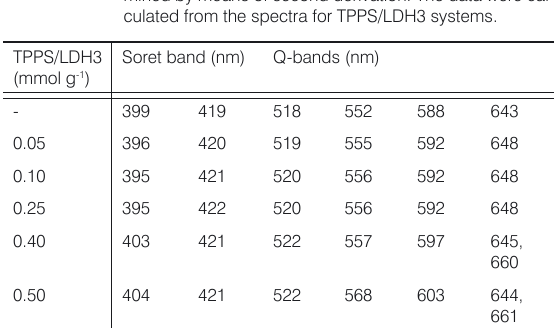
Table 1. Position of absorption bands in the visible region deter- mined by means of second derivation. The data were cal- culated from the spectra for TPPS/LDH3